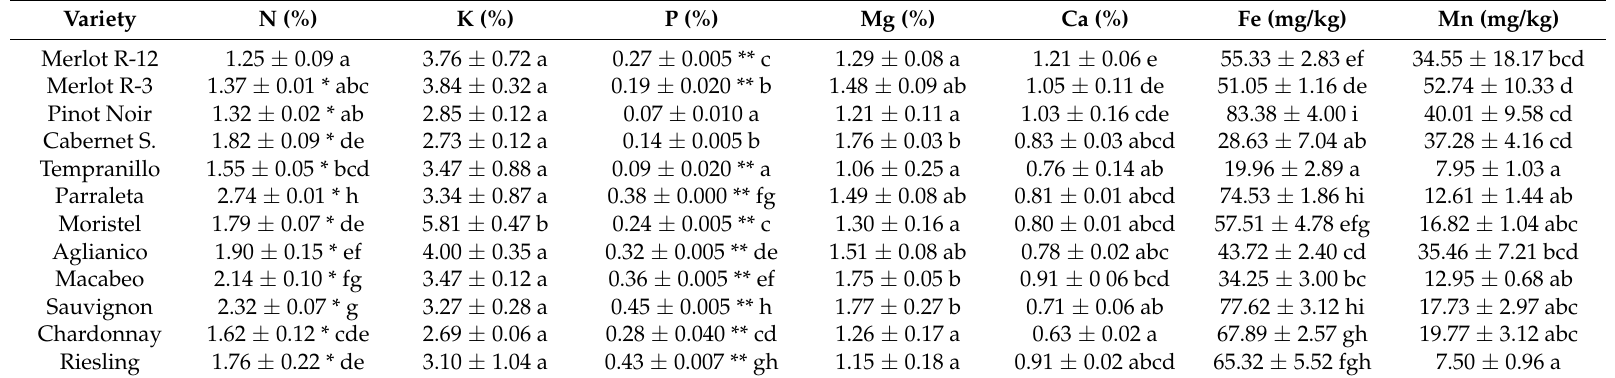
Table 3. Petiole analyses results (on dry weight) at the fruit set stage for the different grapevine varieties. Variety